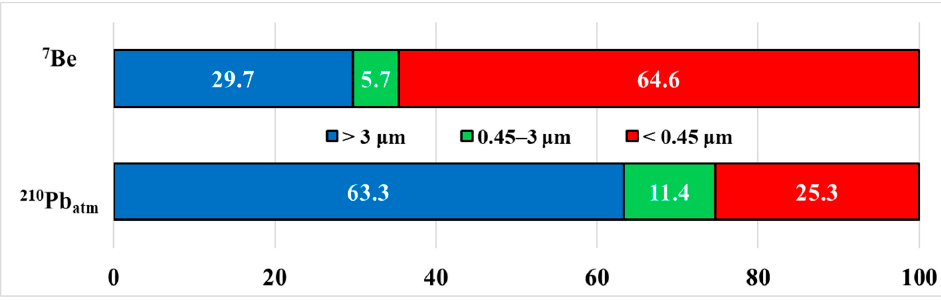
Figure 7. Average values of 7 Be and 210 Pb atm specific activities in the particulate fractions of suspended matter in snow water. For coarse ‐ grained fractions, consisting mainly of large dust particles, the 7 Be/ 210 Pb atm ratio is equal to 1.1–1.2. The 7 Be/ 210 Pb atm ratio of the finely dispersed fraction is much higher—6.1. The low values of the 7 Be/ 210 Pb atm ratio typical for coarse ‐ grained fractions could indicate that these particles represent the material whose radionuclide composition was formed long before its entry into the atmosphere and subsequent precipitation onto the Earth’s surface as a part of dry deposition and snowfall. In this case, the low content of 7 Be can be explained by its short half ‐ life. It could also be that dust particles raised into the air from the surface as a result of various atmospheric processes initially contain increased concentrations of non ‐ equilibrium 210 Pb. Their sorption ability might have been insufficient for significant accumulation of 7 Be when particles were in the atmosphere. There is most likely an influence by both of these. The high value of 7 Be/ 210 Pb atm ratios in the finest fraction, despite the significant influence of the 7 Be radioactive decay process, confirms the fact that the finely dispersed aerosol component is the carrier concentrator of this isotope. Figure 8 shows that there are five pathways for air masses to arrive at YNAD from their distant sources during winter period. The cluster ‐ mean 5 ‐ day backward air ‐ mass trajectories analysis suggested that air masses over Novy Urengoy are mostly from Kazakhstan (20%) and the western region of Russia (20%). Air masses originating in Kola Peninsula, Greenland and Canada accounted for 16%. Trajectories from the Ob estuary and Novaya Zemlya accounted for 26% and the north of